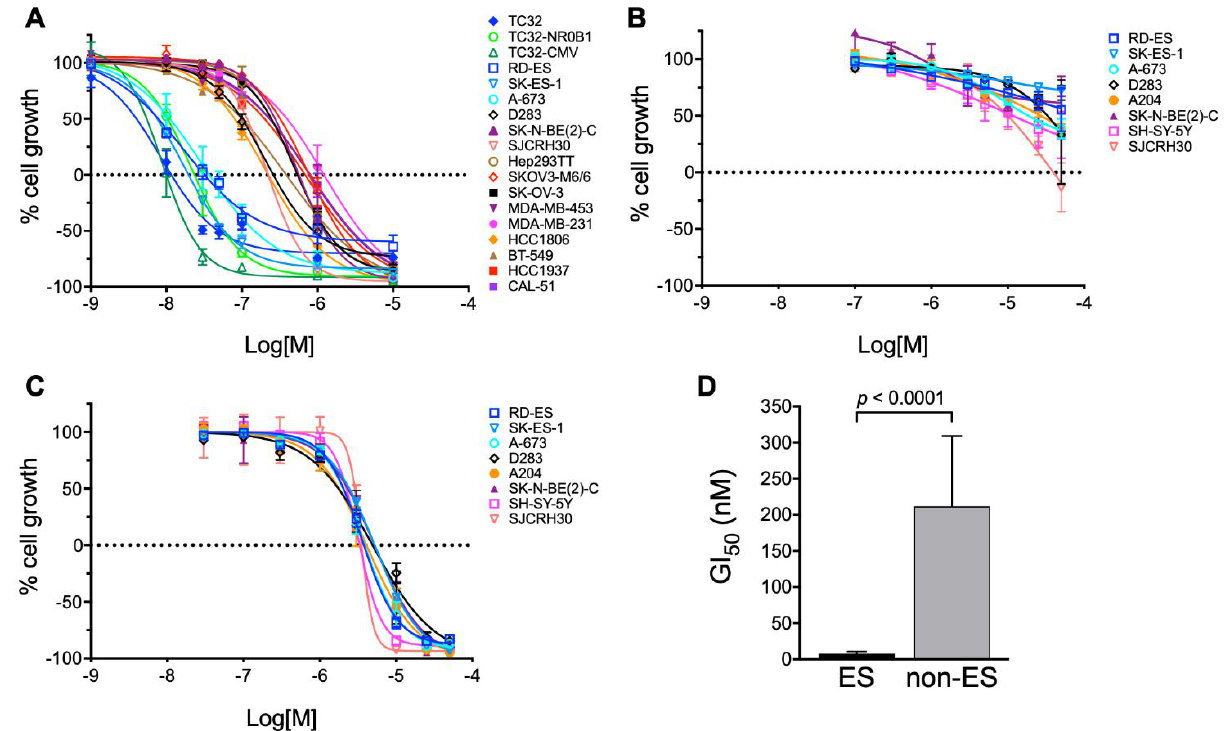
Figure 2. ATXII, but not altertoxin I or alteichin, has selective activity against Ewing sarcoma cells in vitro. ( A ) Sulforho- damine B (SRB) concentration-response curves for the inhibition of cell growth by ATXII, ( B ) altertoxin I and ( C ) alteichin. Results represent mean ± SE; n ≥ 3 independent experiments with each concentration tested in triplicate. ( D ) Comparison of GI 50 (concentration resulting in 50% inhibition of cell growth relative to vehicle-treated control) for ATXII in EWS and non-EWS pediatric cancer cell lines. Results represent mean ± SD. Groups compared by two-tailed t -test.